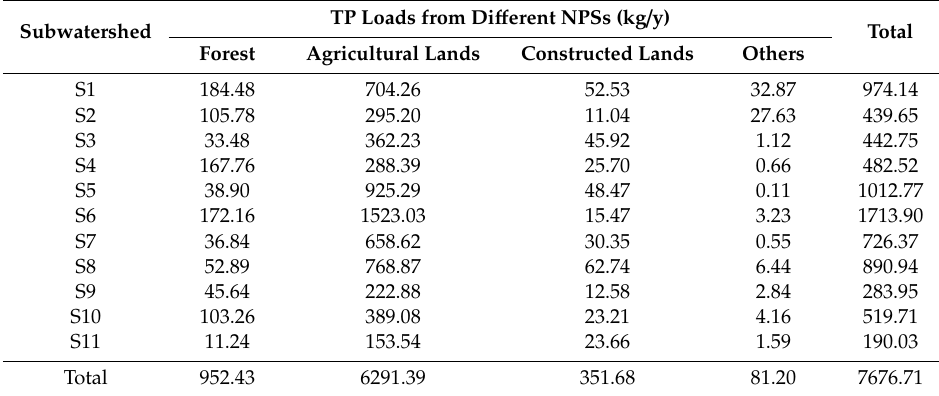
Figure 9. The pollution hot spots, subwatersheds S5 and S7, were suggested as priority water quality control areas. Table 4. The TP loads from different NPSs.